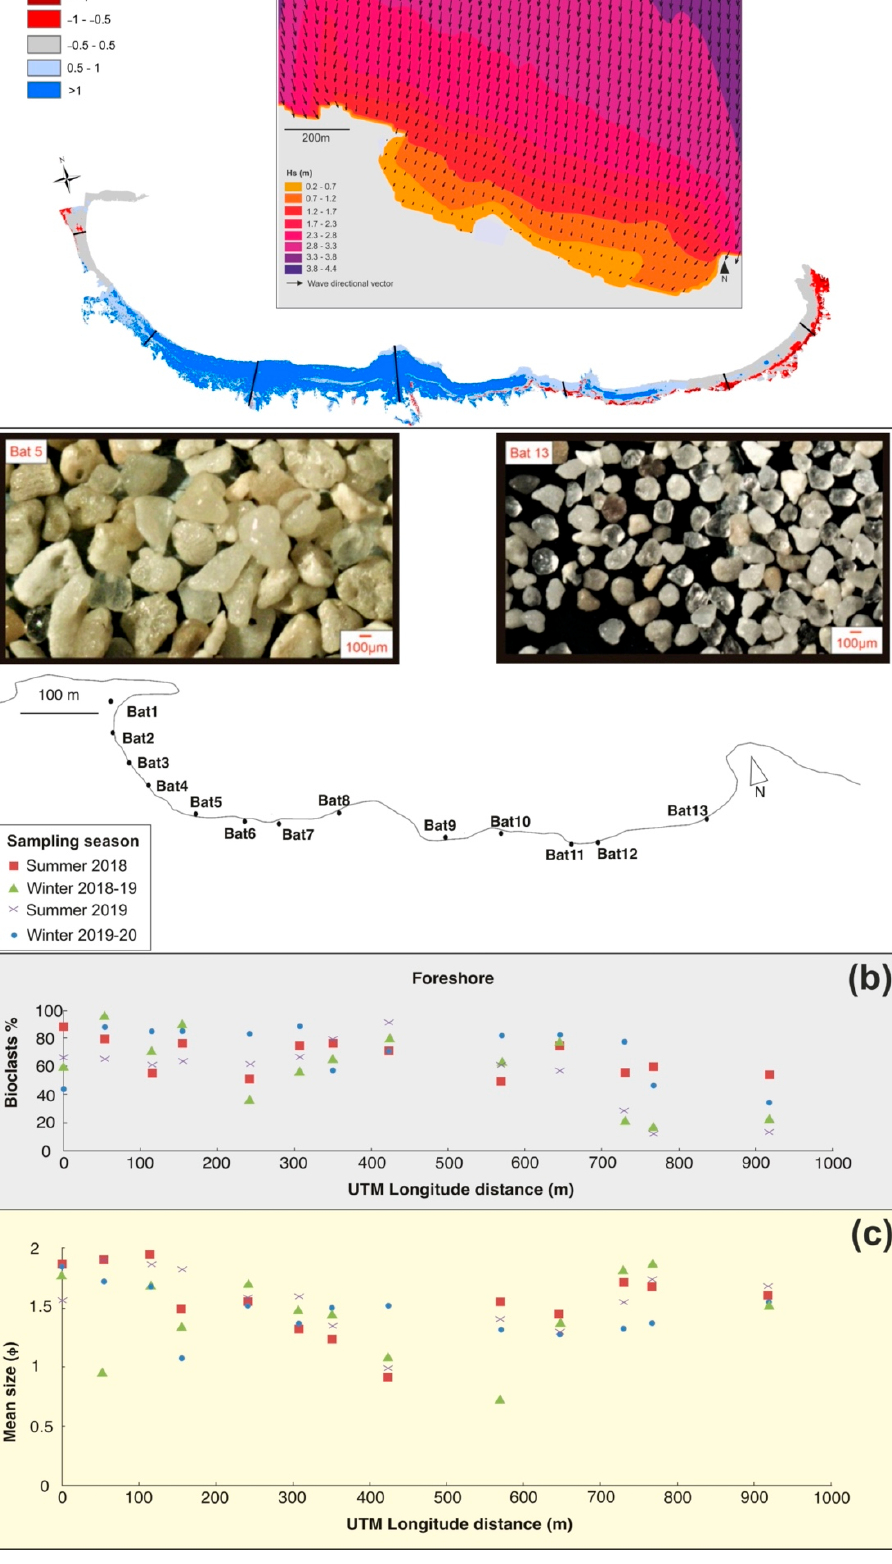
Figure 13 . Example of emerged beach sector analysis. ( a ) Comparison between DTM investigation and Delft3D Model; ( b ) bioclast analysis and ( c ) mean size investigation for longshore sediment distribution.